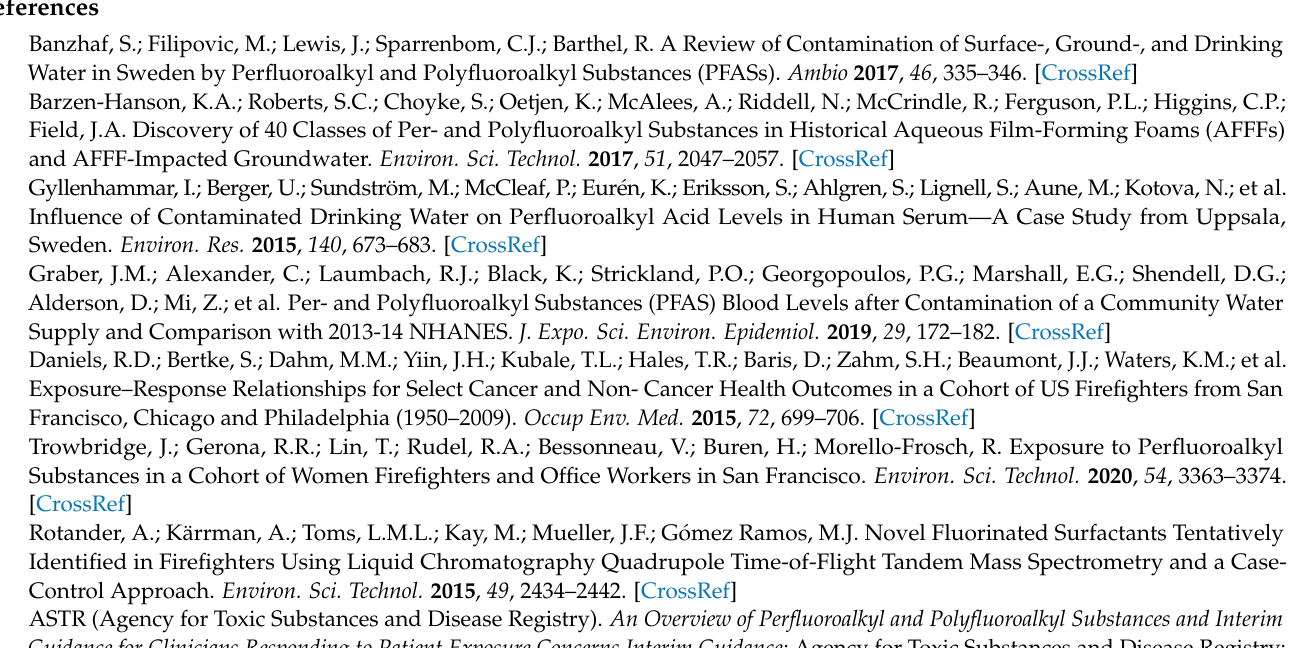
for LC-QTOF-MS acquired data (Screening parameters), Table S5.3: 19F and 1H NMR acquisition LOQ, and extraction recoveries (LCMS target compounds), Table S6.2: Qualified PFAS in AFFF using suspect-screening (LCMS qualified PFAS), Table S6.3: Qualified hydrocarbon surfactants in of total fluorine quantified in AFFF using HPLC-QTOF-MS and 19F NMR (Total fluorine quant), Table S7.2: Experimentally determined and molecular docking predicted HSA-PFAS association constants (Ka_docking and exp), Table S7.3: Kruskall-Wallis one-way pairwise ANOVA analysis on docking predicted HSA (1E7G) binding affinities of long-chain PFAS and hydrocarbon surfactants identified in AFFF (Kruskall-Wallis